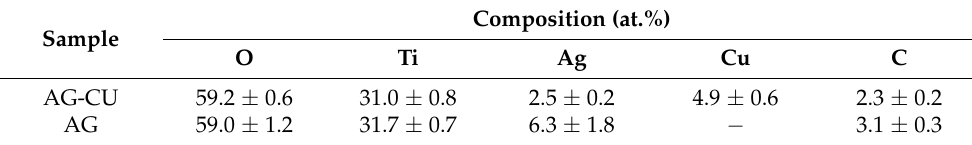
Table 1. Surface composition of samples (mean ± SD).